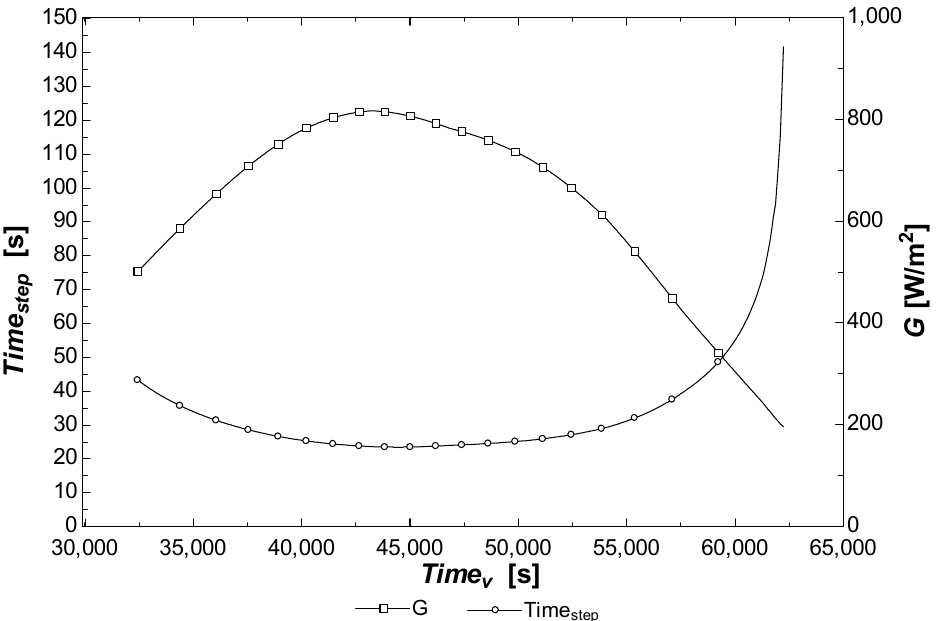
Figure 2. Time step daily distribution confronted with incoming solar radiation; May in Manila.